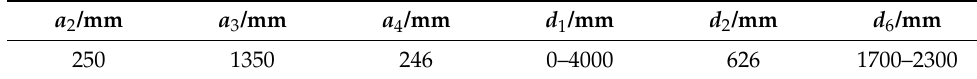
Table 2. Robot’s structural parameters.